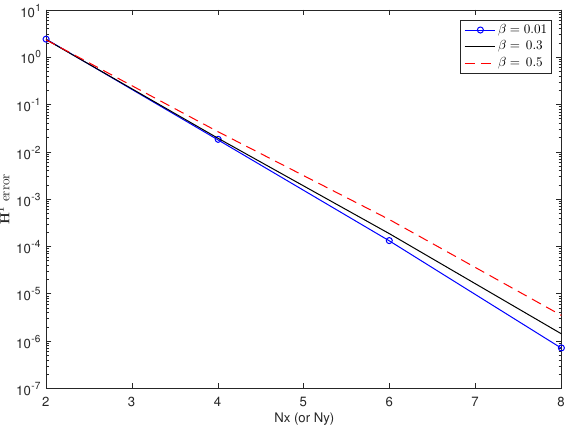
Figure 6. H 1 errors versus N x , N y when β = 0.01, 0.3,